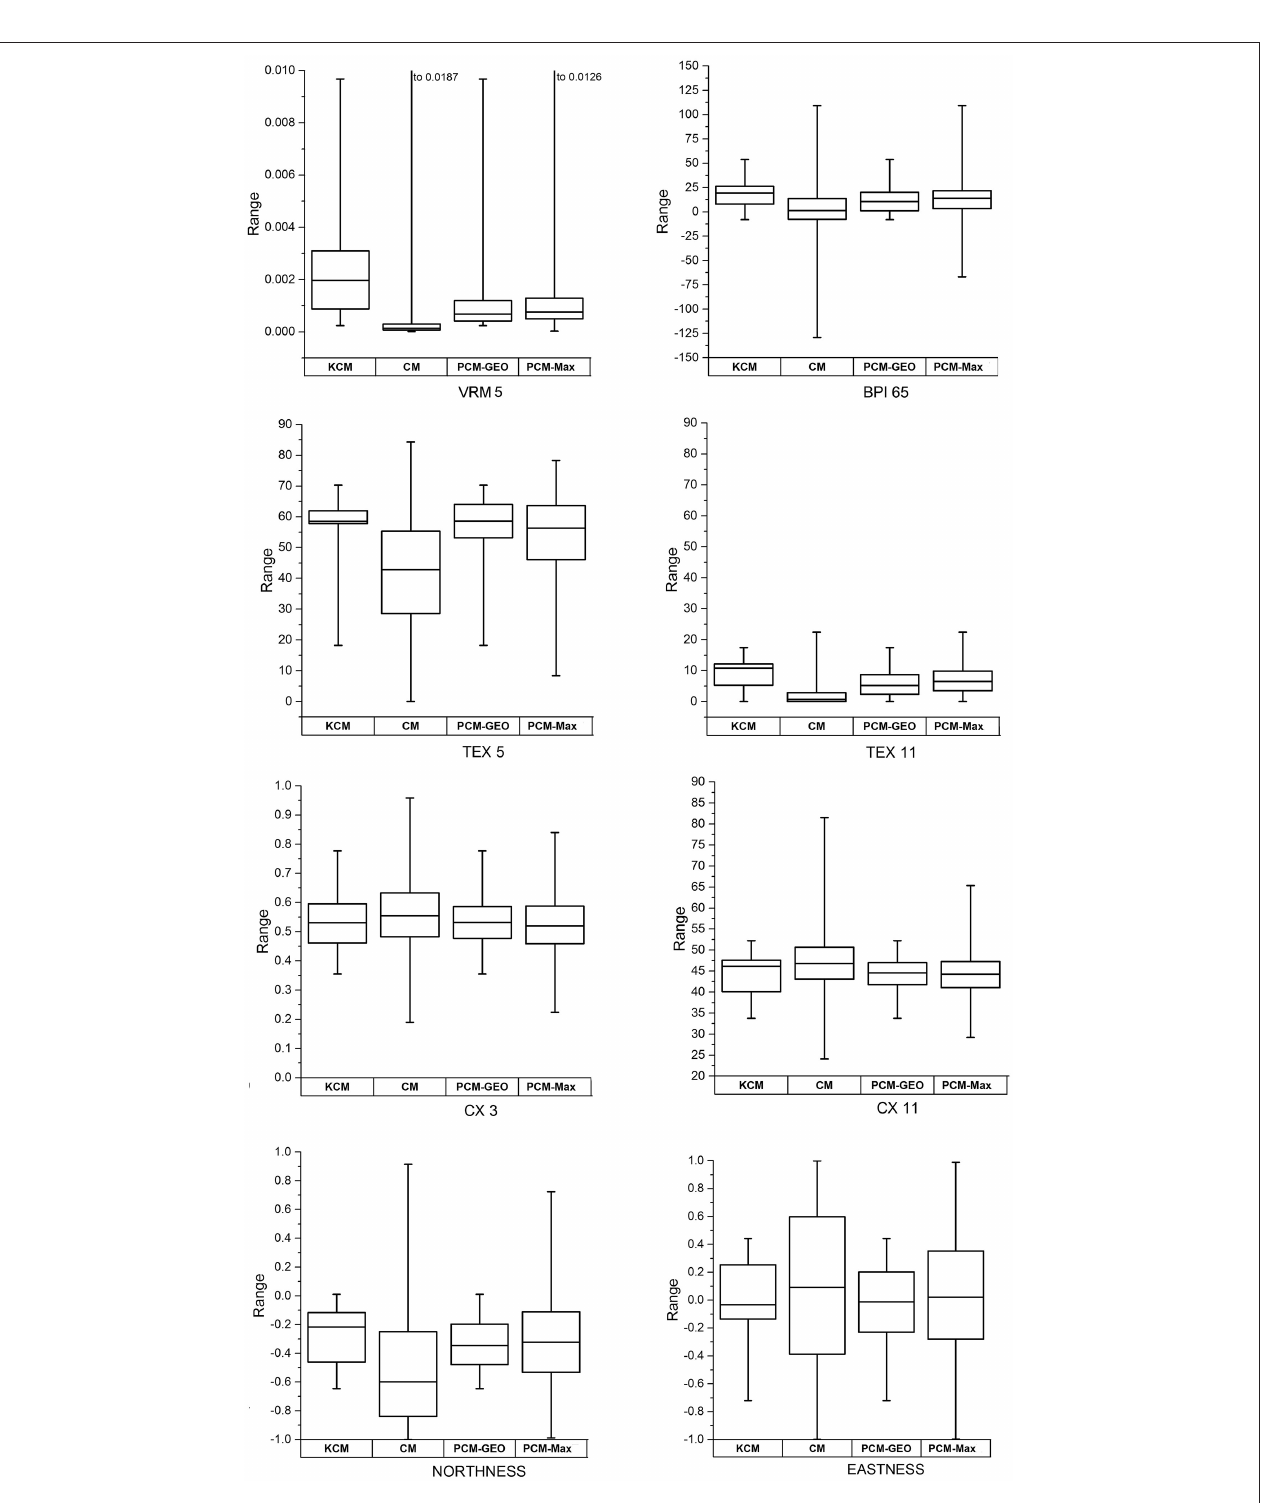
FIGURE 3 | Boxplots of eight non-correlated bathymetric indices used in the study, computed on polygons of known coral mounds (KCM), candidate morphologies (CM), probable coral mounds obtained with the Geomorphometric proxies method (PCM-Geom) and probable coral mounds obtained with the Maxent method